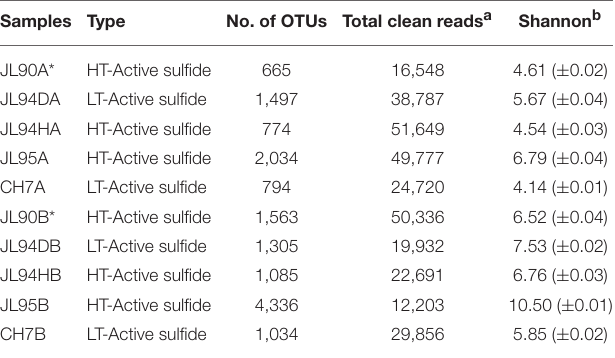
TABLE 2 | Diversity estimates from 16S rRNA amplicon libraries: miseq tag sequences. Samples Type